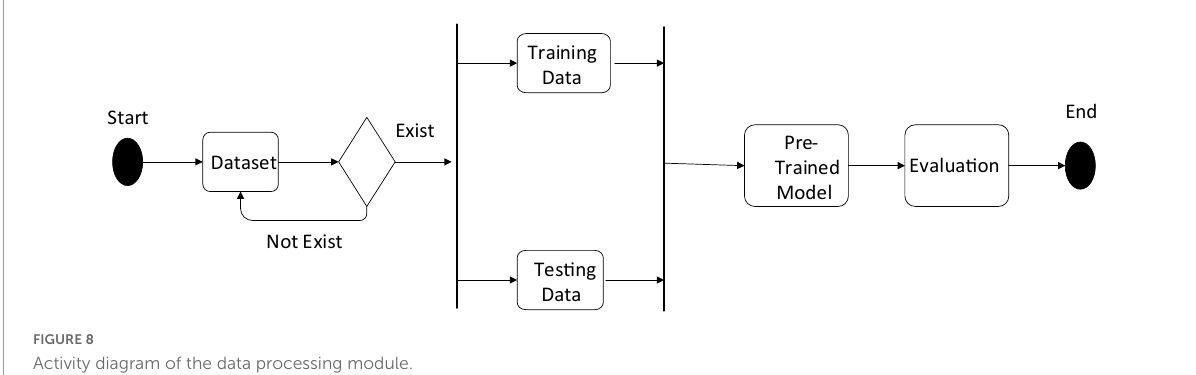
FIGURE8 Activity diagram of the data processing